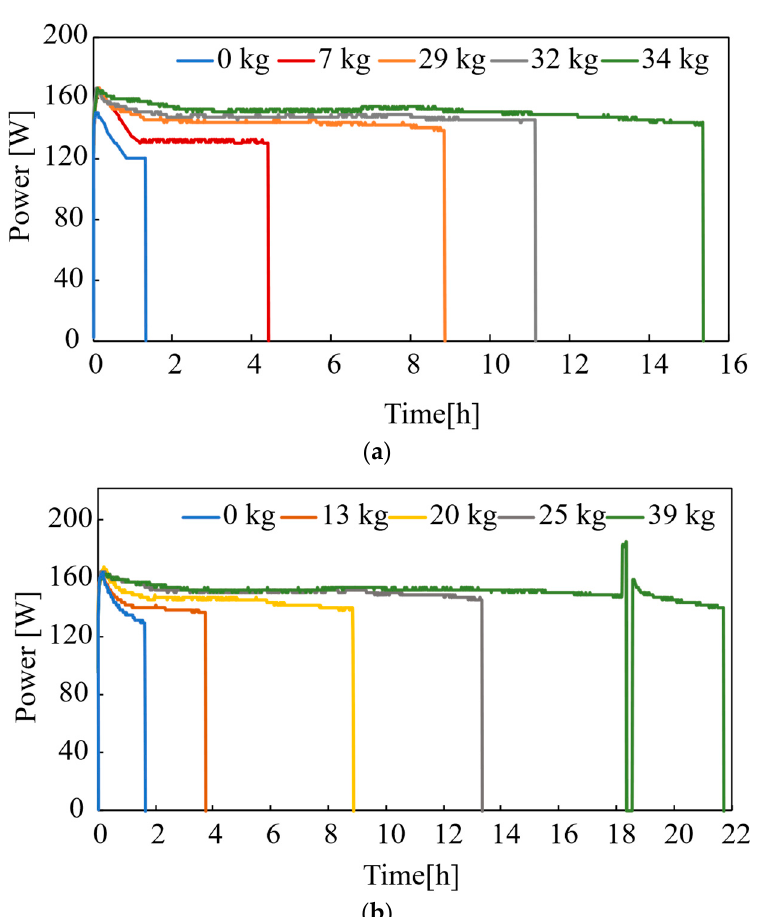
Figure 6. Power during the first on-state of the compressor: ( a ) room temperature at 20 °C; ( b ) room temperature at 25 °C.